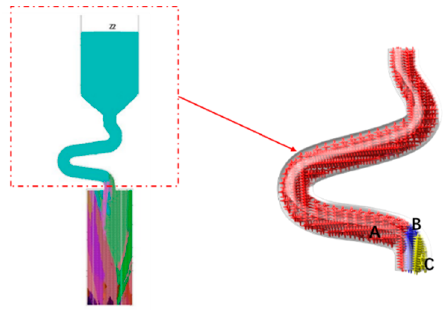
Figure 19. Simulation results in the selector parts of Z 1 (15°) take-off angle.